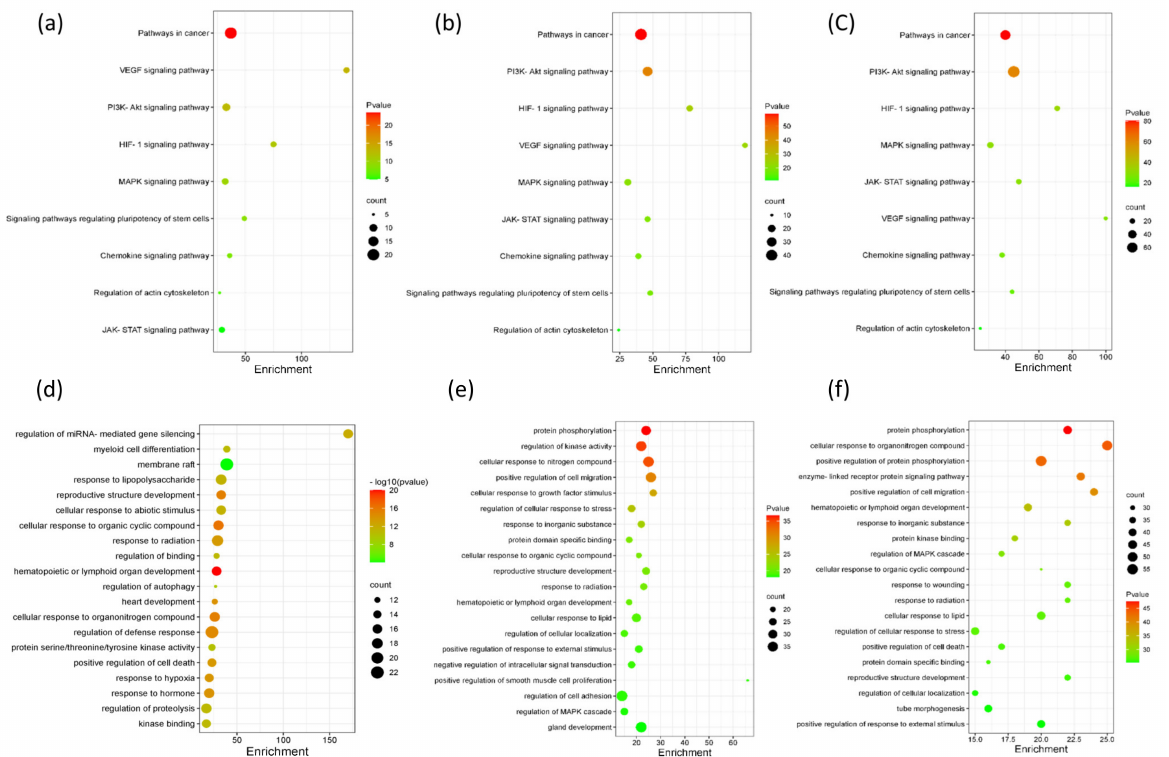
Figure 5. KEGG analysis ( a – c ) and Gene Ontology ( d – f ) enrichment analysis of the target proteins of metabolites. Metabolites from plasma ( a , d ), urine ( b , e ) and feces ( c , f ).